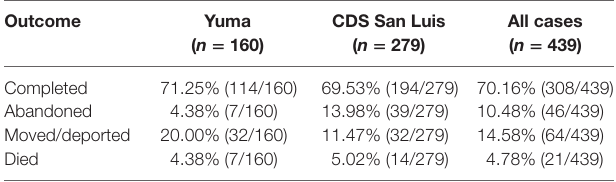
TaBle 2 | Treatment outcomes: completed, abandoned, moved/ deported, died.